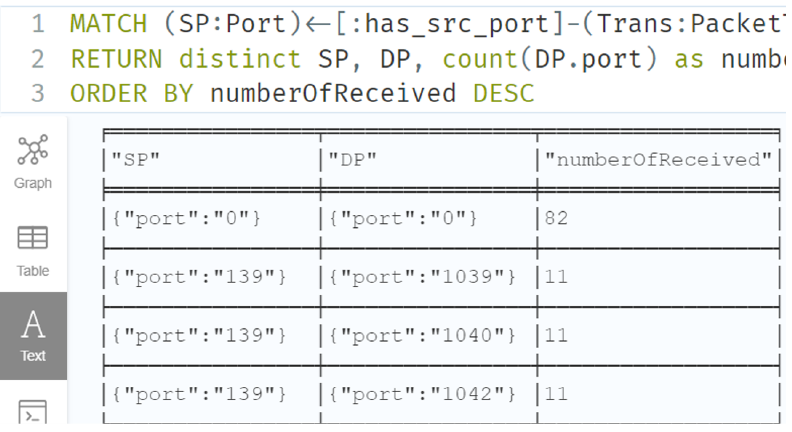
Figure 10. Numbers of the same source sending a packet to closed ports.